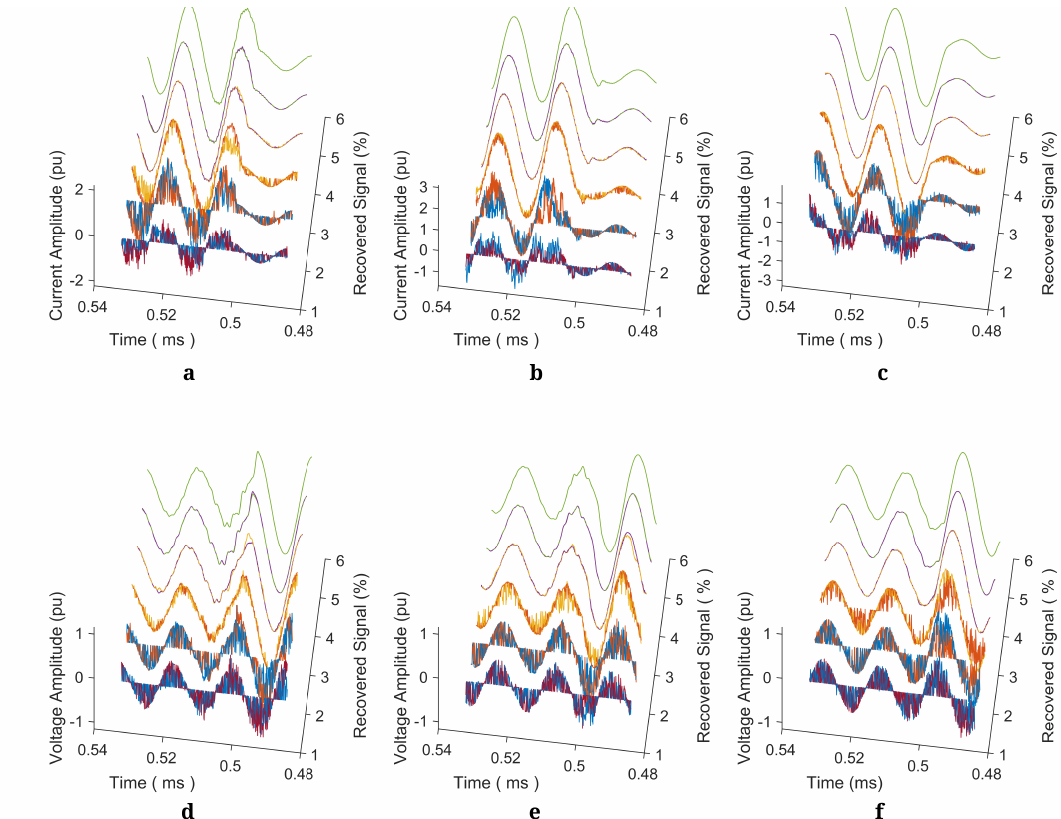
Figure 12. Signal reconstruction using m values vs. processing time (( a – c ) current and ( d – f ) voltage at bus